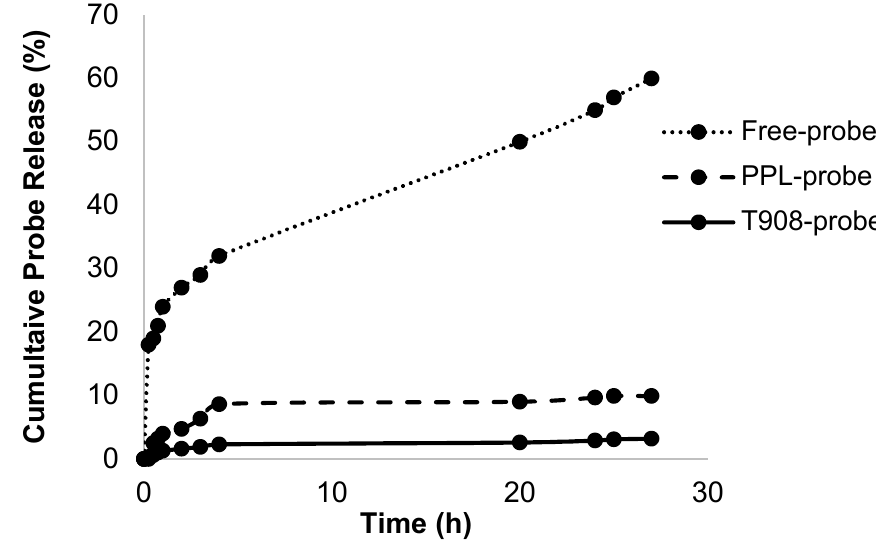
Figure 5. In vitro cumulative probe release percentage of free-probe, PPL-probe, and T908-probe, during 30 h. The concentration of probe was 50 µ g/mL, and the sink conditions in the experiment were maintained in all cases.